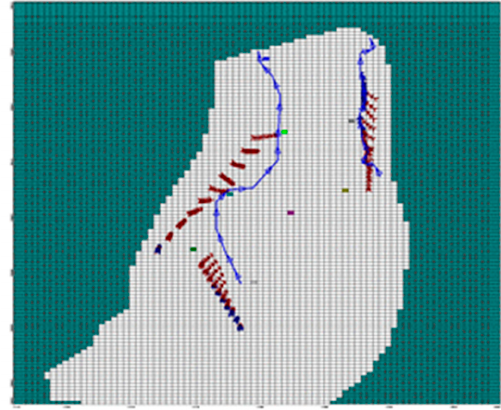
Figure 7. Particle tracking from the stream boundary.